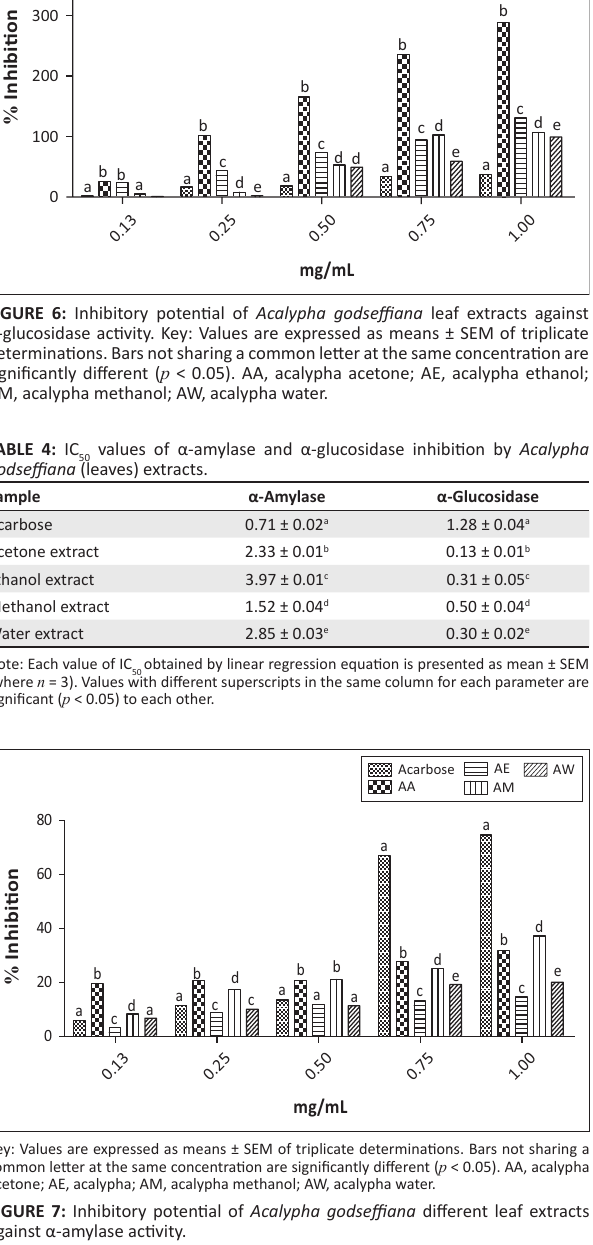
FIGURE 7: Inhibitory potential of Acalypha godseffiana different leaf extracts against α-amylase activity.